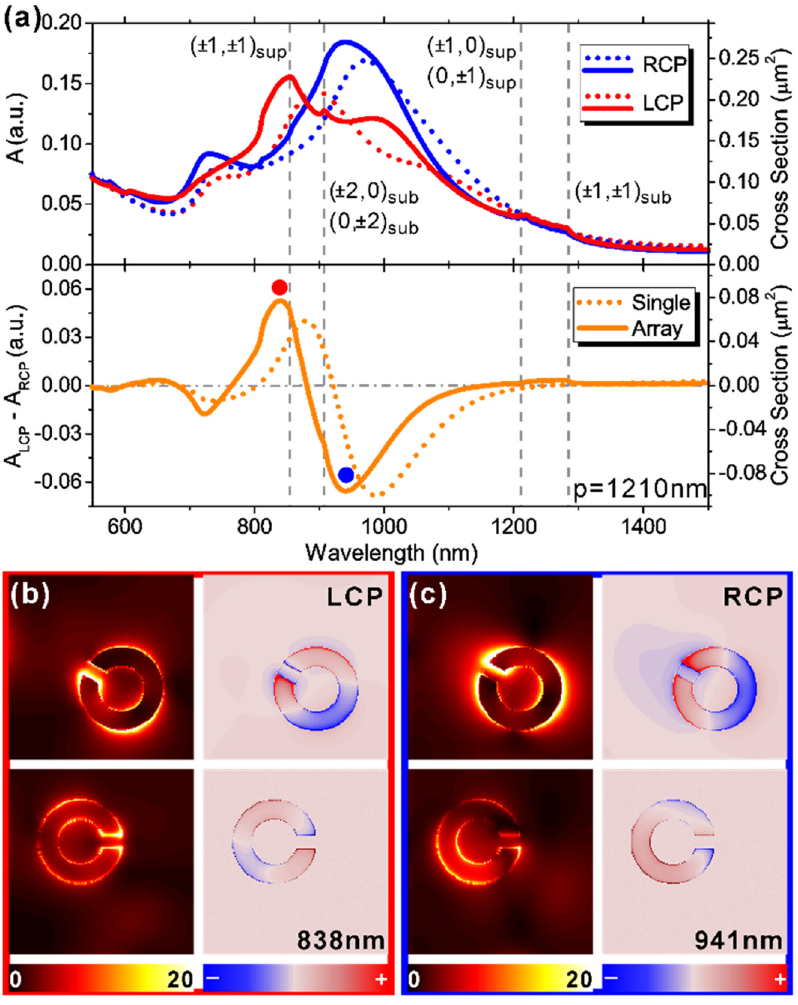
resonances, that is, the antibonding (ABDD) and bonding (BDD) dipole-dipole resonances (inset of Figure 8a). Compared with single chiral quadrumer whose ensemble CD signal is smaller than 0.1 (dotted line, magni fi ed by 5 times for a better visualization), the positive CD peak located at 1320 nm is enhanced by 10 times. As shown in Figure S9, we also simulate the transmission spectra and calculate corresponding transmission CD of these struc- tures under circular polarized illumination from the substrate side, which reveal slightly reduced CD values with negligible polarization conversion, thereby con- fi rming the presence of intrinsic chirality in these struc- tures [50]. The near- fi eld distributions of LSPR modes shown in Figure S8 indicates that the CD peak (CD = – 0.42) located at 1103 nm stems from the diffraction RA in the substrate. In coupling of ABDD mode by (1, 1) sub addition, the sharp peak around 1320 nm is the (1, 0) sup SLR mode by the diffraction coupling of the BDD mode in